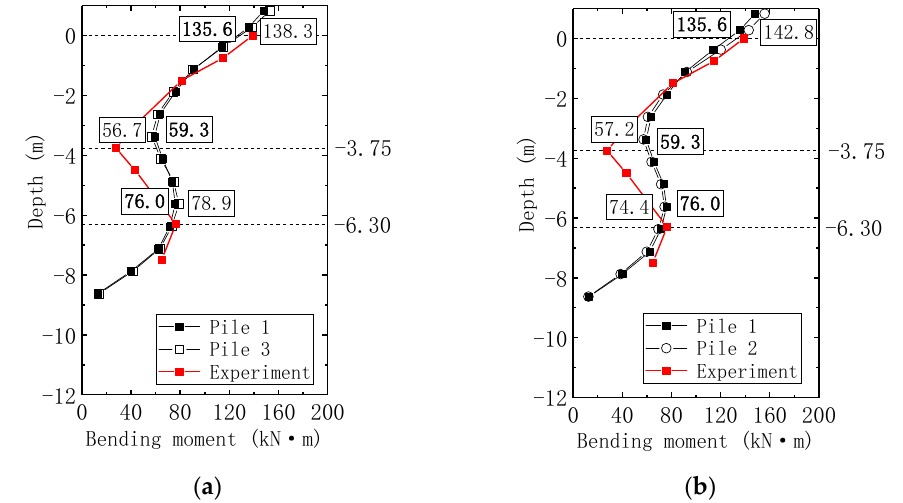
Figure 18. Arrangement of four-pile group.